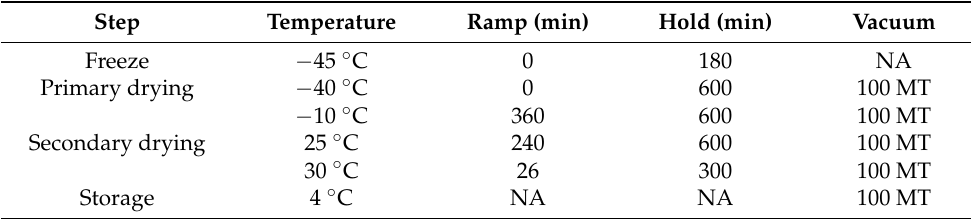
Table 1. Freeze-drying cycle for production of heat-stable sublingual